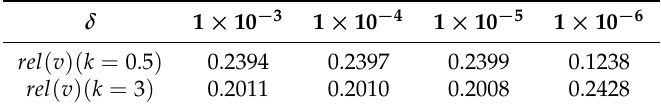
Table 1. The relative error rel ( v ) of Example 1.